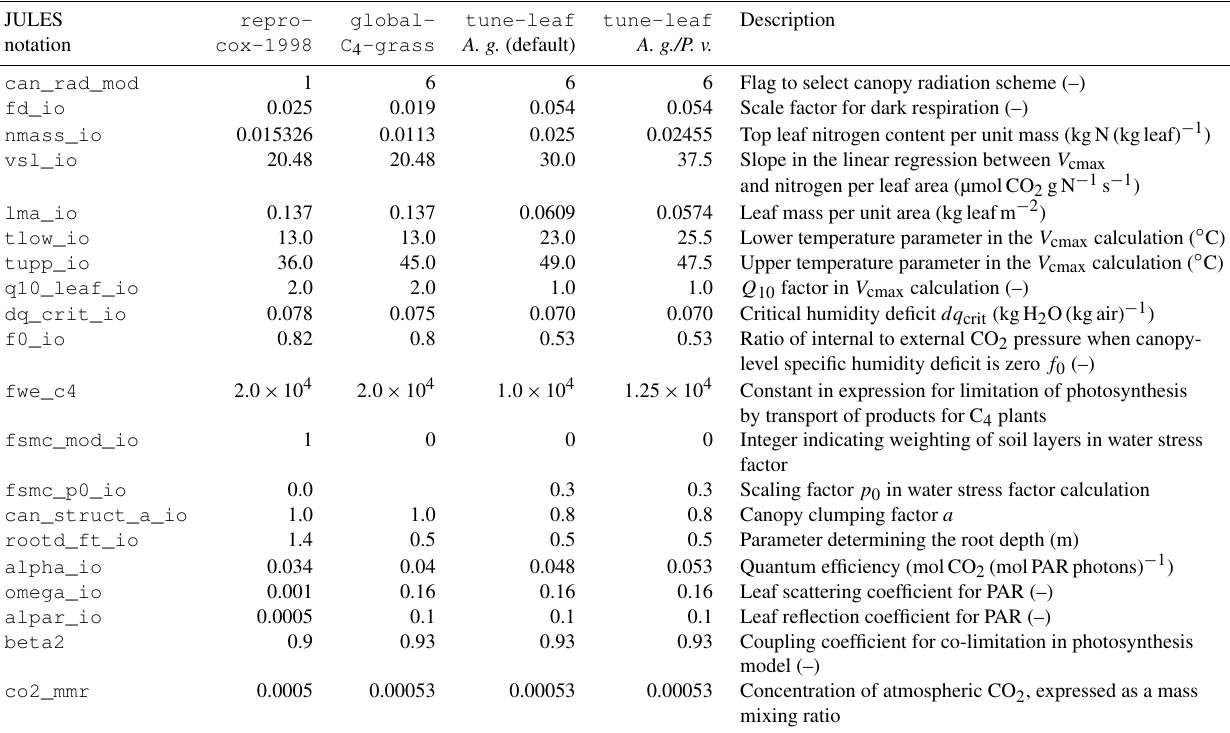
Figure A5. (a) Derived soil moisture dataset, on model soil levels. (b) Derived soil moisture in the top layer, compared to the gravimetric soil moisture measurements for 2.5 and 7.5cm from FIFE_SM_NEUT_111. Table A2. JULES parameters used to represent vegetation at FIFE site 4439, which vary across runs. These parameters are all spec- ified in the JULES_PFTPARM namelist apart from can_rad_mod ( JULES_VEGETATION ), co2_mmr ( JULES_CO2 ) and beta2 ( JULES_SURFACE